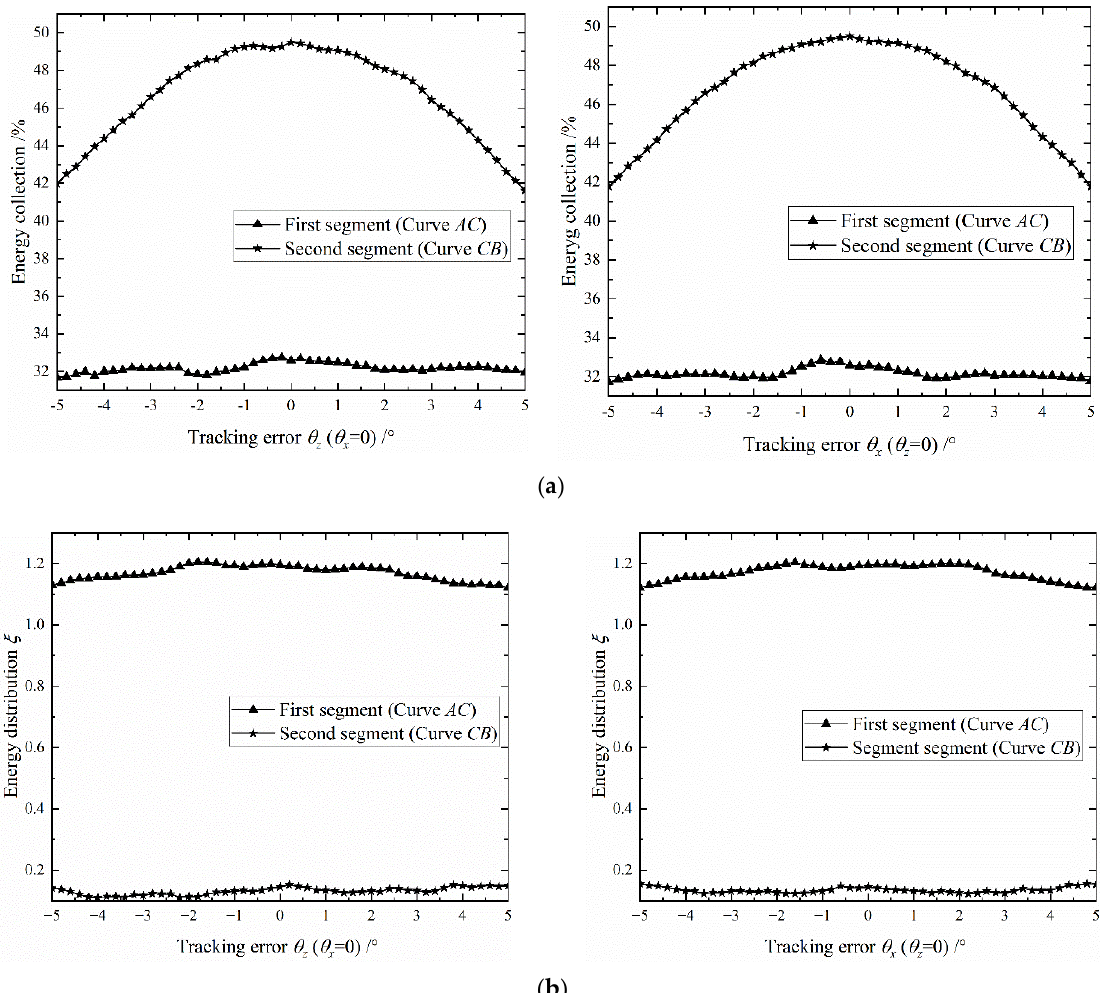
Figure 15. Energy collection and distribution of different segments: ( a ) Energy collection; ( b ) Energy